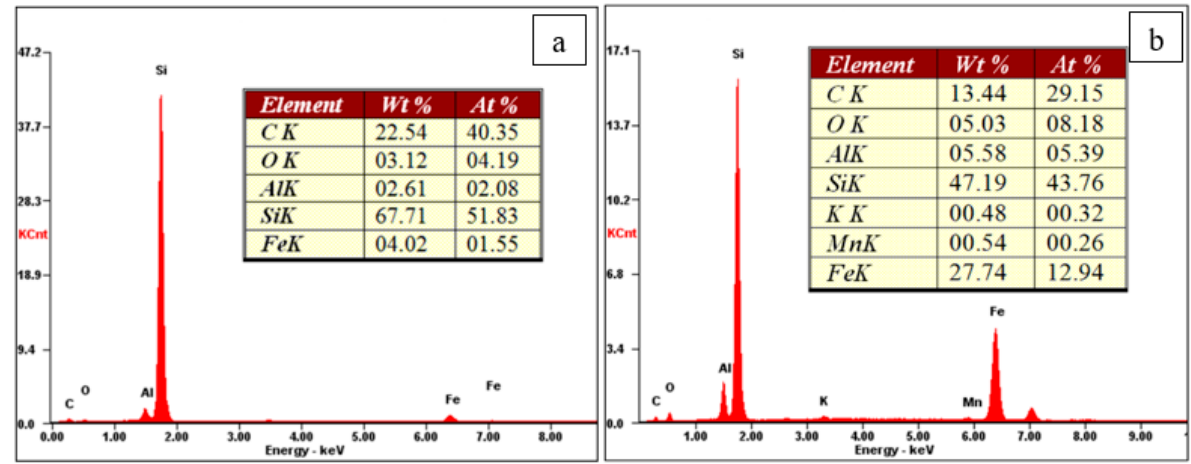
Figure 36. Elemental composition of obtained coatings: Sample No. 1 ( a ), Sample No. 2 ( b ). Table 6. Comparison of micro-hardness and synthesis time of silicon-carbon coatings obtained by different